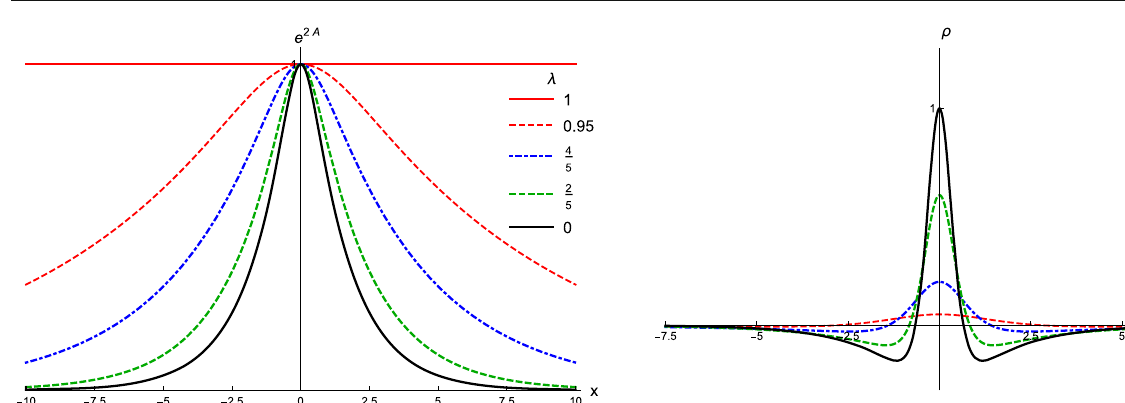
Fig. 10 The warp factor that follows from (50) for some values of λ . Here we see how it evolves from the sine-Gordon case when λ = 0 to a 5-dimensional flat spacetime when λ = 1